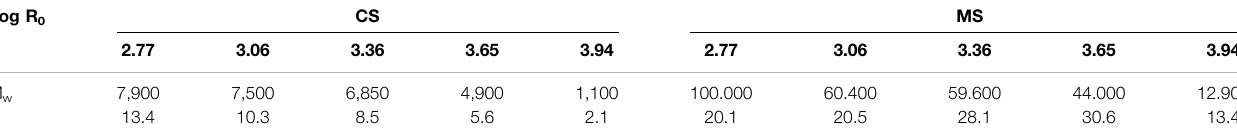
TABLE 3 | Average molar mass (M w ) in g/mol and dispersity ( Đ ) measured by SEC for CS and MS fi ltrates. Log R